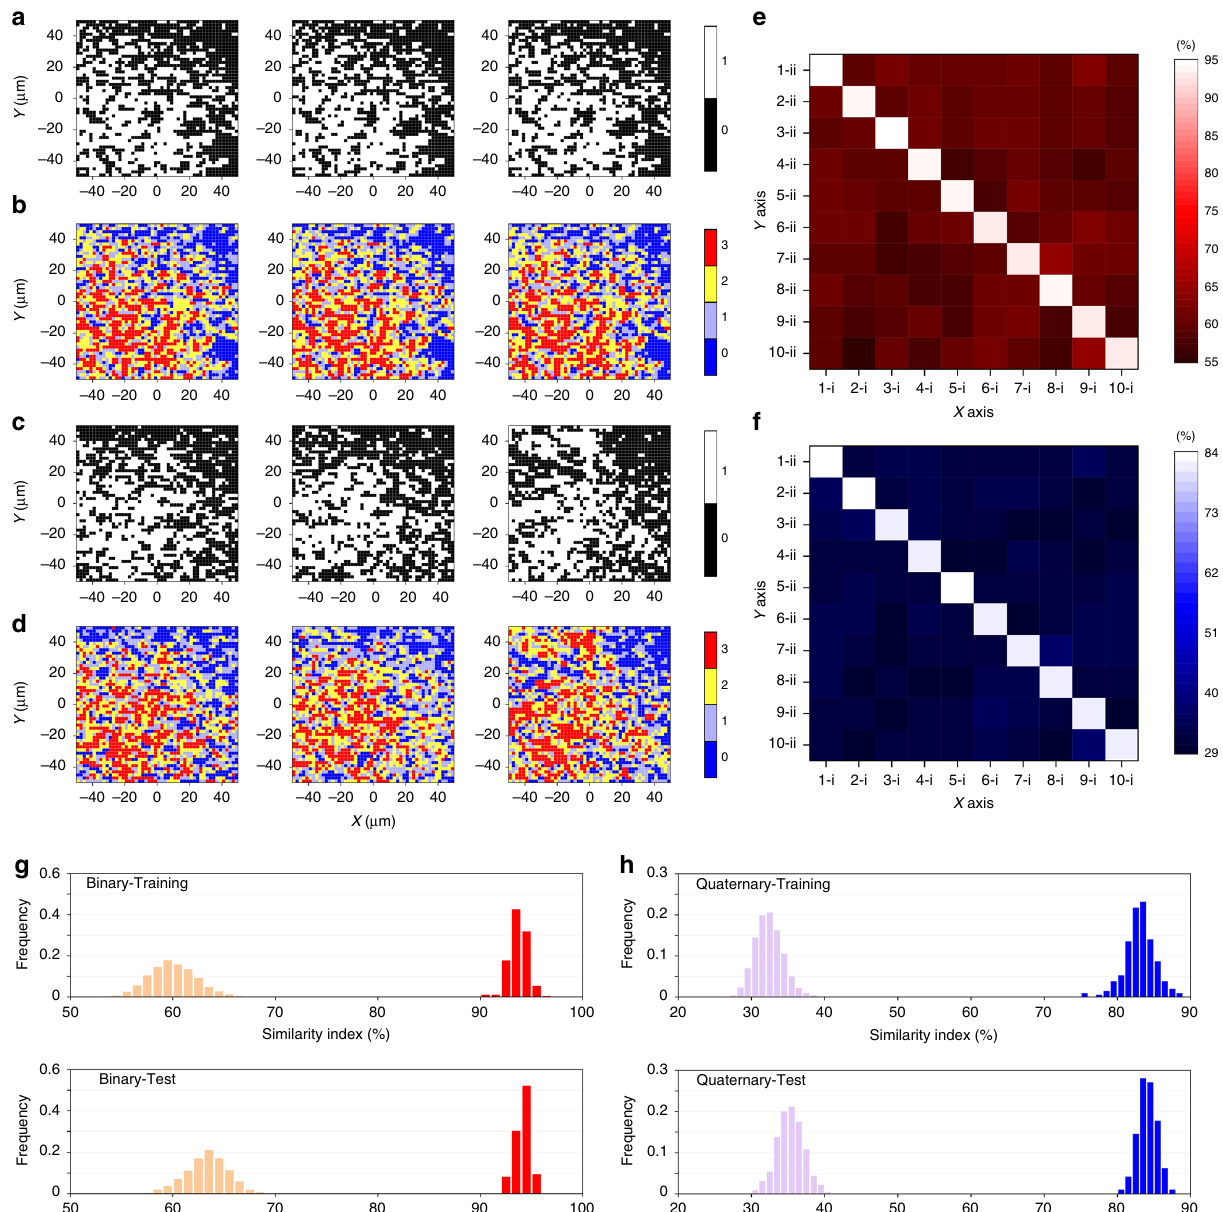
Fig. 5 Reproducibility veri fi cation of PUF labels. A PUF label composed of 4-NBT GERTs in a 100 × 100 μ m 2 area is read with a resolution of 50 × 50 pixels and is digitized with a binary and b quaternary encoding of Raman intensity levels at each pixel for the fi rst (left), second (middle), and third (right) measurement. Digitization of additional three labels numbered 2 (left), 3 (middle) and 4 (right) for c binary and d quaternary encoding of Raman intensity levels at each pixel with a resolution of 50 × 50 pixels. Pairwise match of ten PUF labels with e binary and f quaternary encoding of Raman intensity levels at each pixel. The x- axis and the y- axis represent the fi rst and the second measurement of the labels, respectively, and the color bar shows the similarity index. Distribution of the similarity indexes ( I ) for the same PUF labels (red and blue bars) and those for different labels (orange and purple bars) of the training set (top) and the test set (bottom) in terms of g binary and h quaternary encoding of Raman intensity levels at each pixel. Figure e and f are plotted by referring to the ref. 17 . Source data are provided as a Source Data fi